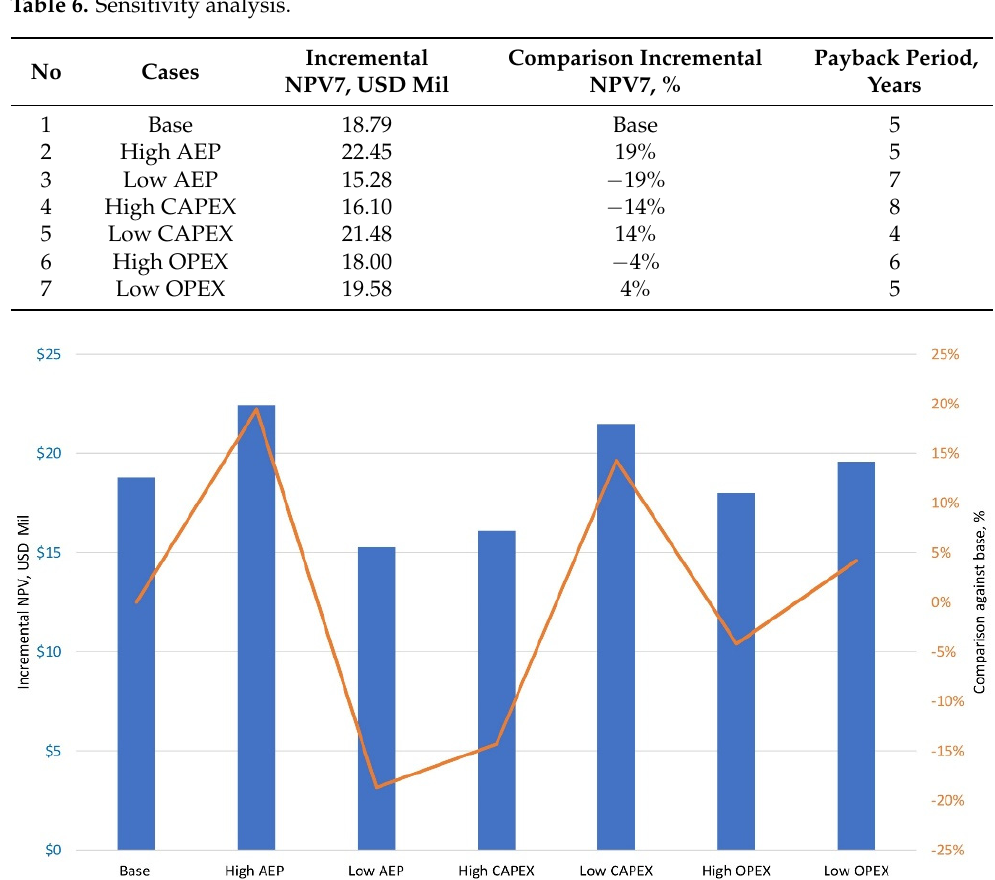
Figure 9. Sensitivity analysis-graphical illustration.